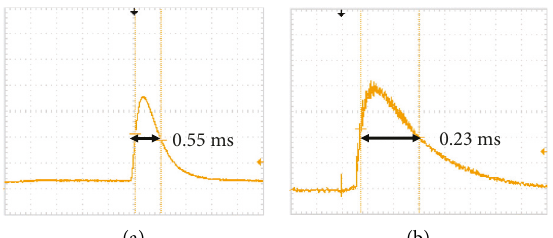
Figure 8: Temporal waveform. (a) Xe flash lamp light. Pulse duration: FWHM 0.55ms. (b) Output laser pulse. Pulse duration: FWHM